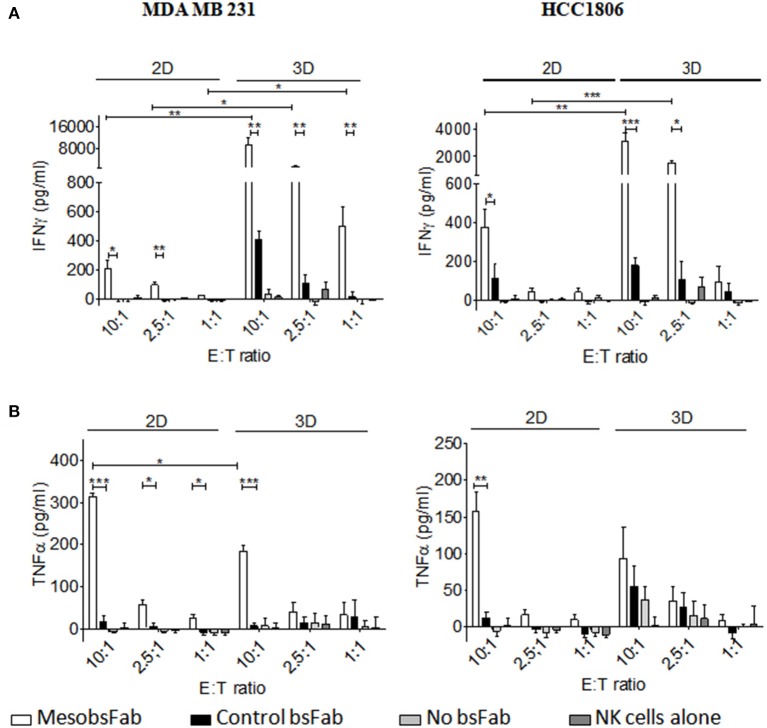
MesobsFab mediates potent IFNγ secretion. IFNγ (A) and TNFα (B) were quantified by ELISA in the culture medium harvested from ADCC assays. Experiments, performed in technical triplicate, are representative of at least three independent donors. Data represent the mean ± SEM and were analyzed by two-tailed Student's t-test. MesobsFab vs. control bsFab: *P < 0.05, **P < 0.01, ***P < 0.001; MesobsFab 2D vs. MesobsFab 3D *P < 0.05, **P < 0.01, ***P < 0.001.